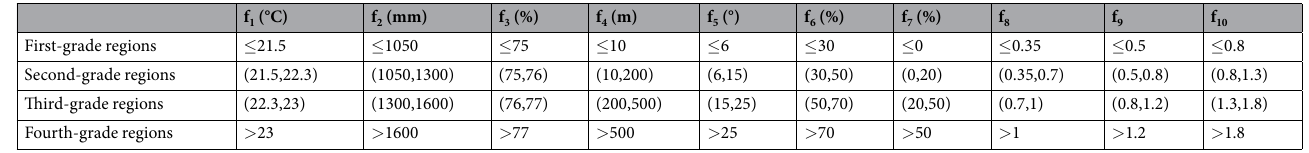
Table 5. Impact factor partitions for the identified geographical